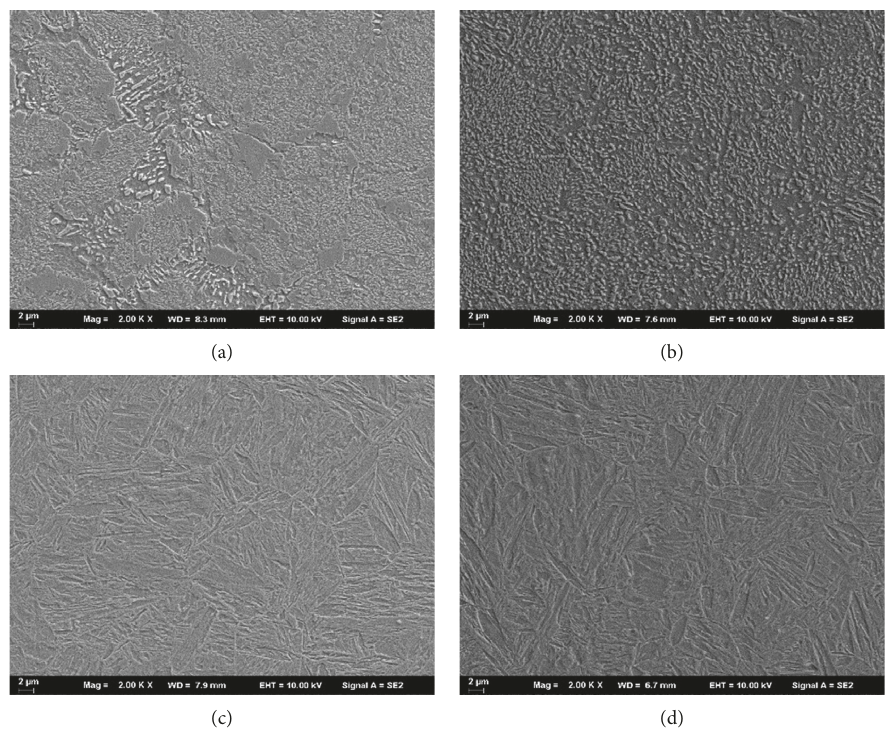
Figure 4: The metallographs of 34CrNiMo6 steel with different ratios of Al to N. (a) No Al element added. (b) The ratio of Al to N is 2.2. (c) The ratio of Al to N is 2.8. (d) The ratio of Al to N is